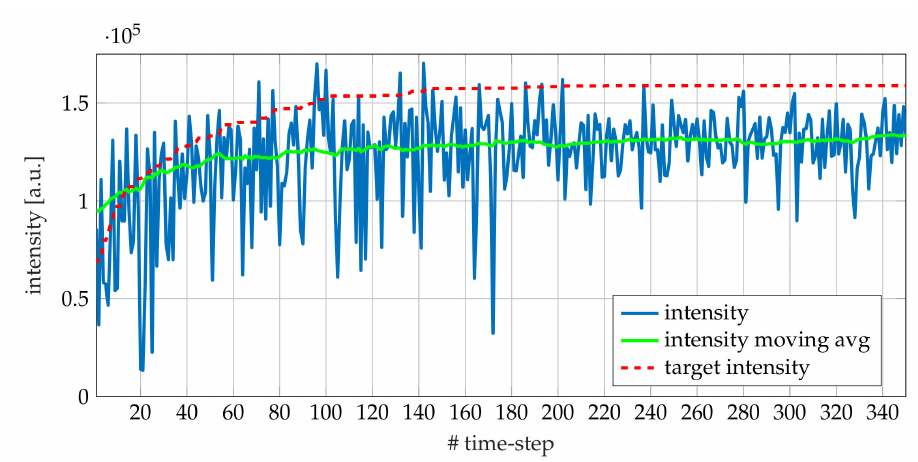
Figure 7. Intensity during a single run of Natural Policy Gradient (NPG) REINFORCE on EOS. The blue line represents the detected intensity, while the green line is its moving average obtained with a fixed window size of 50 samples. The dashed red line represents the target intensity. Until time-step 200 the improvement of the intensity is appreciable; a further evidence is the update of the target intensity. In the remaining time-steps, the target intensity exhibits only small updates.